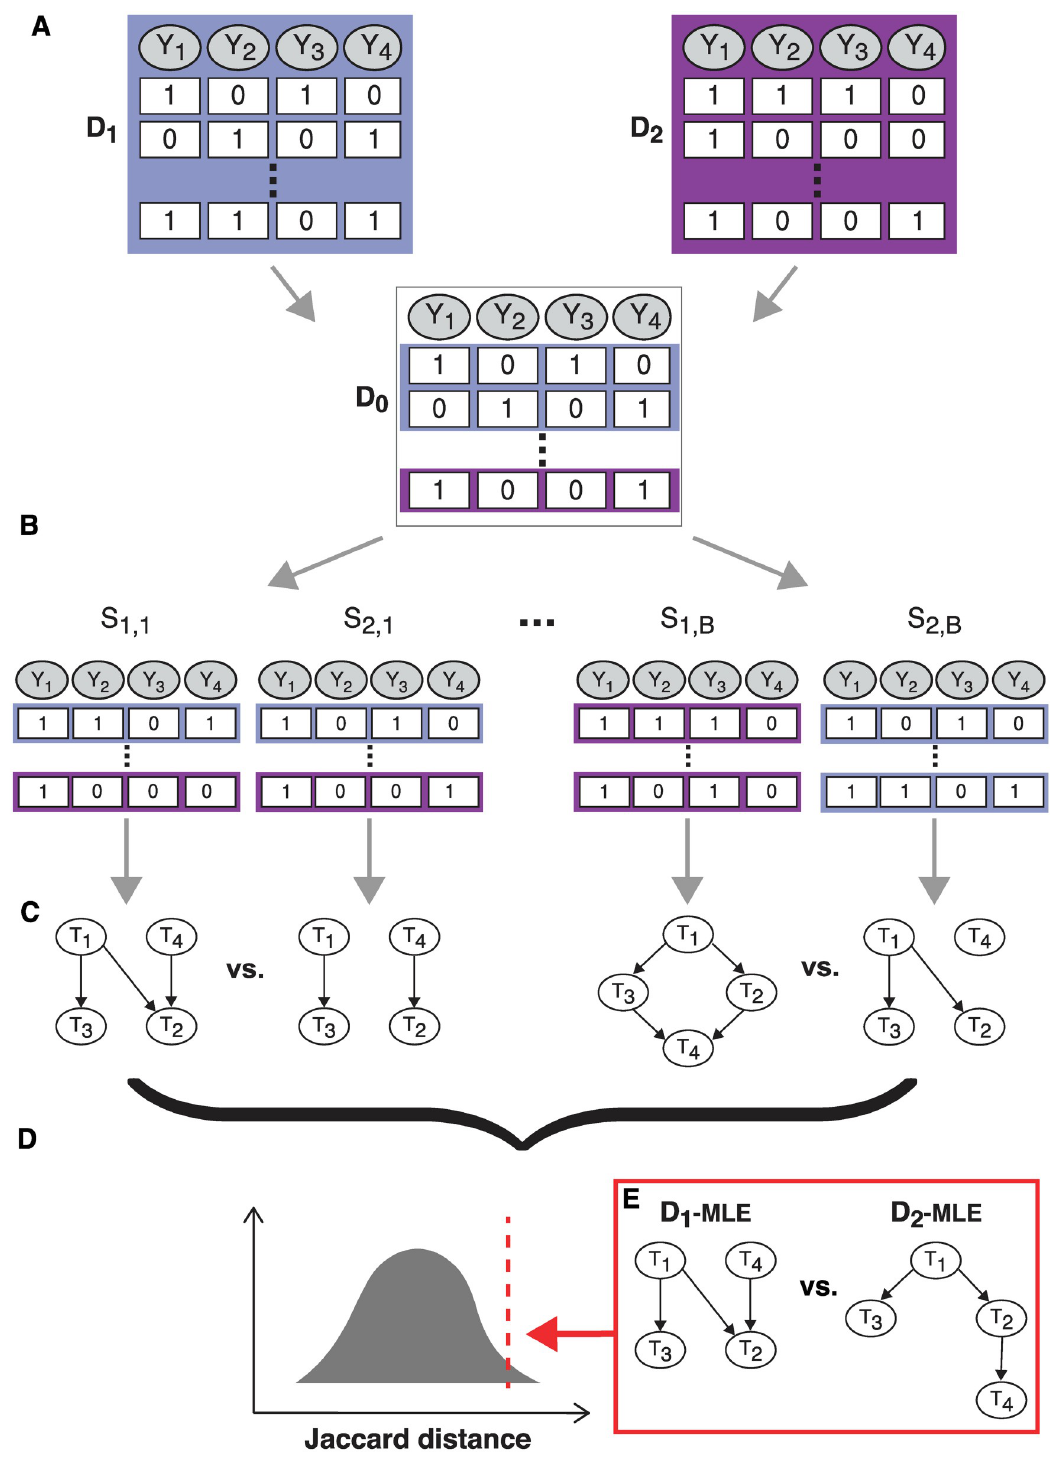
Fig 1. Schematic representation of the comparison of CBN models. A Data sets D 1 and D 2 consist of N 1 and N 2 genotypes, respectively, and, in this example, p = 4 mutations. We combined both data sets into a single one D 0 with N 1 + N 2 genotypes. B We randomly split data set D 0 into data sets S 1 and S 2 and we do so B times. C For each data set, we apply the H-CBN2 approach to learn the structure of the network and for each pair, S 1 and S 2 , we compute the Jaccard distance. D The empirical distribution of the test statistic is computed by aggregating the distances between pairs S 1 and S 2 . E We compare the inferred CBN posets from original data sets D 1 and D 2 by computing the Jaccard distance and assess its significance.